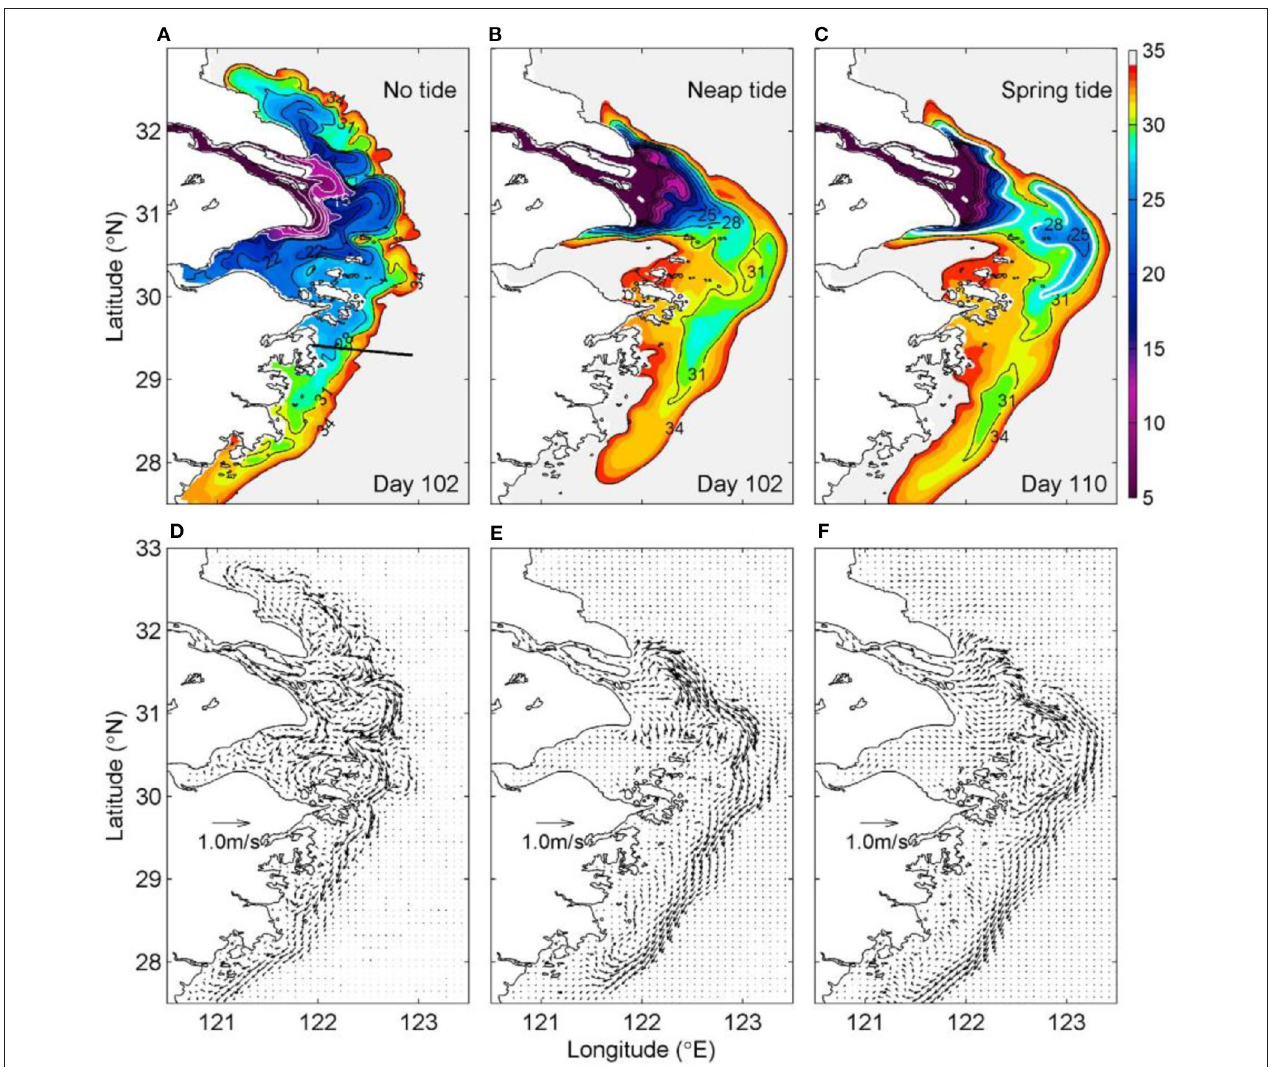
FIGURE 3 | Distributions of (A–C) surface salinity and (D–F) surface currents, respectively, under the condition with (A,D) low discharge without tides, and low discharge with tides during (B,E) neap and (C,F) spring tide periods. The contour interval for surface salinity distributions in (A–C) is 3 psu. This figure is adapted from Li and Rong